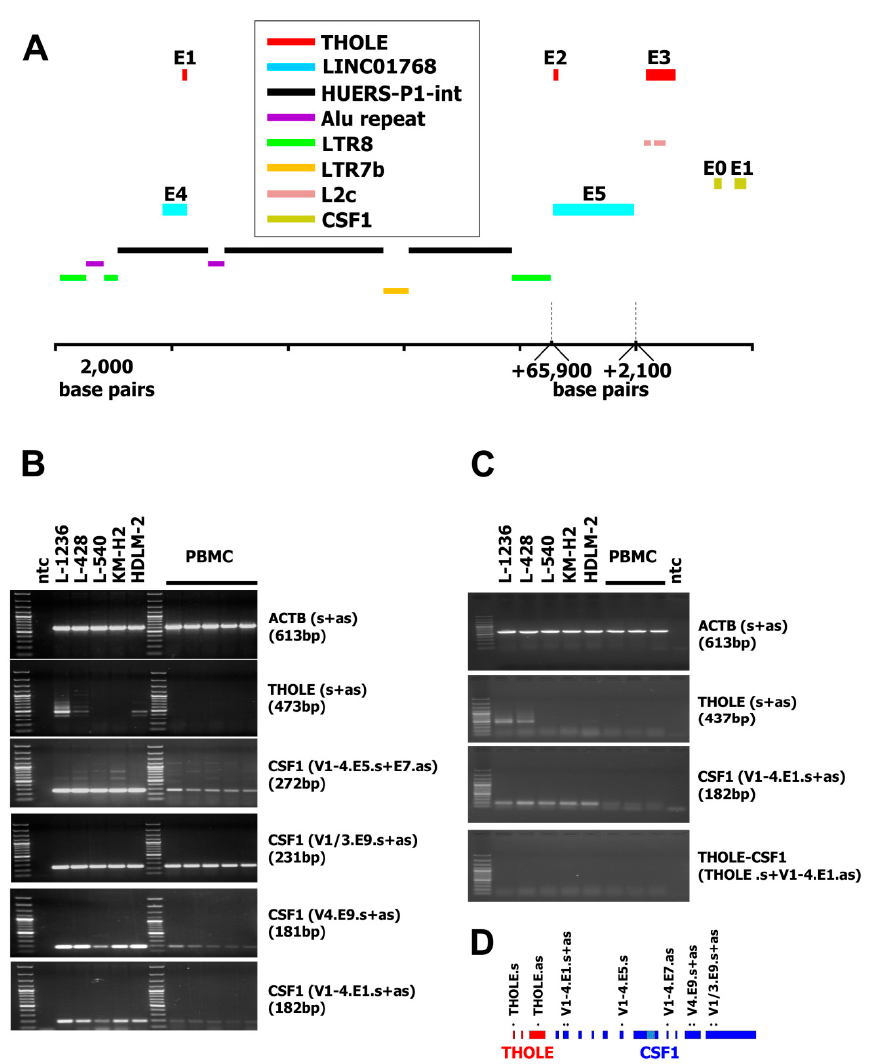
Figure 1. Genomic organization of the LINC01768 / THOLE / CSF1 locus and expression of transcript from Hodgkin lymphoma cells (THOLE) in Hodgkin lymphoma cells. ( A ) The figure shows the location of exons ( E ) and repetitive elements in the predicted LINC01768, THOLE, and CSF1 region